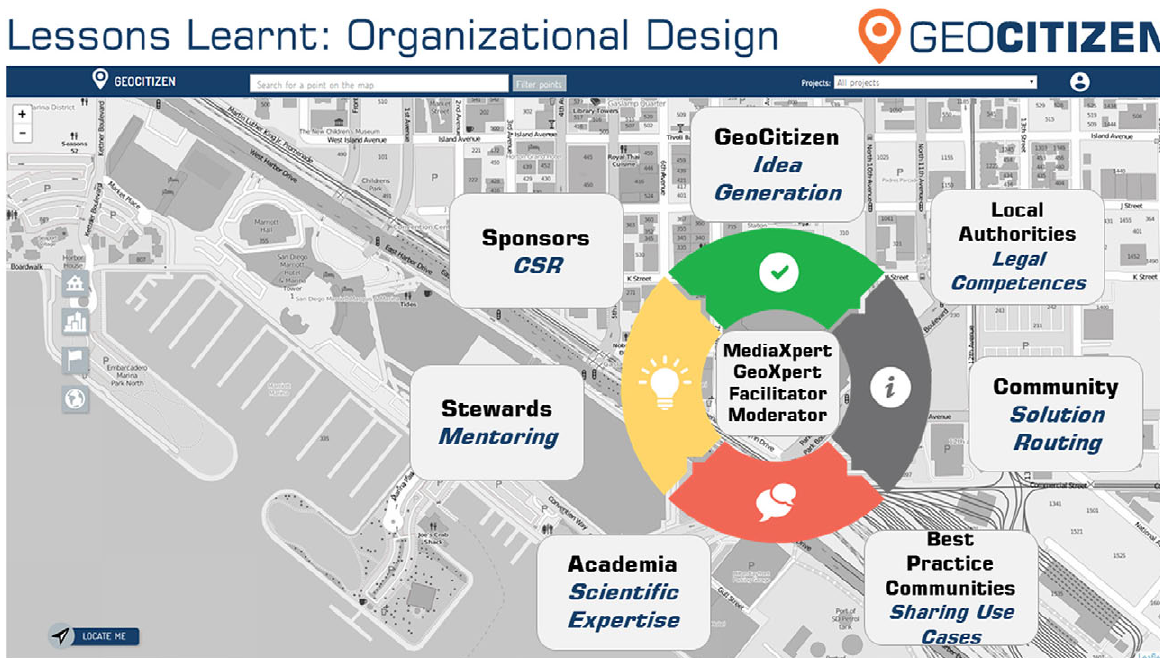
Fig. 4. Organisational design of the GeoCitizen Platform (by T. Blaschke and K.